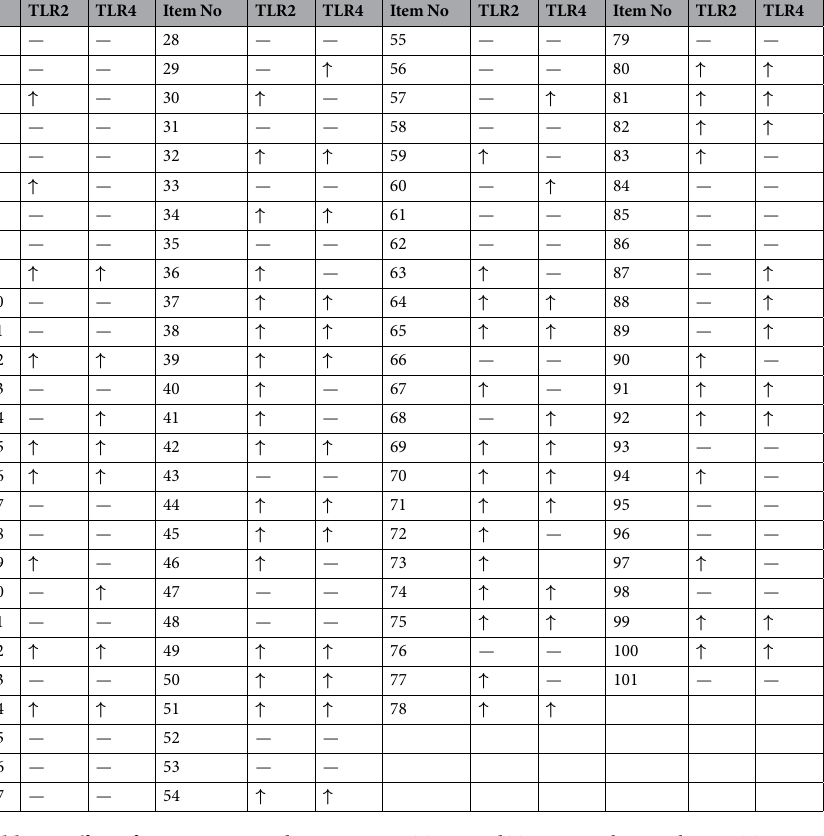
Table 3. Effect of Qing Re Yao and Bu Yi Yao on TLR2 and TLR4 signaling pathways. TLR2: PGN-TLR2 luciferase reporter; TLR4: LPS-TLR4 luiferase reporter. ↓ : inhibition ≥ 50%; ↑ : stimulation ≥ 3 folds; —: no impact at concentration ≤ 750 µ